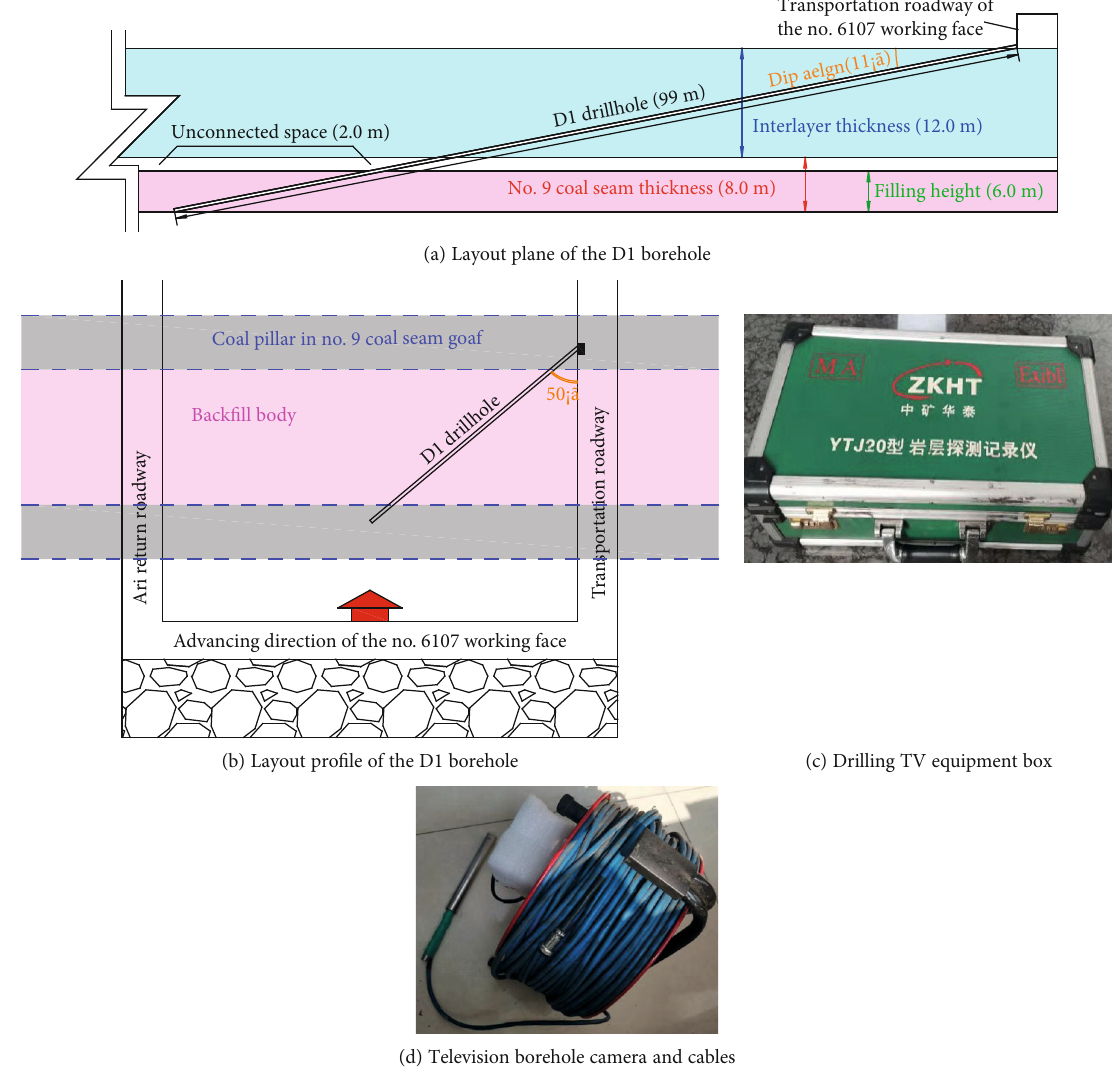
Figure 13: D1 borehole layout diagram and borehole TV observation